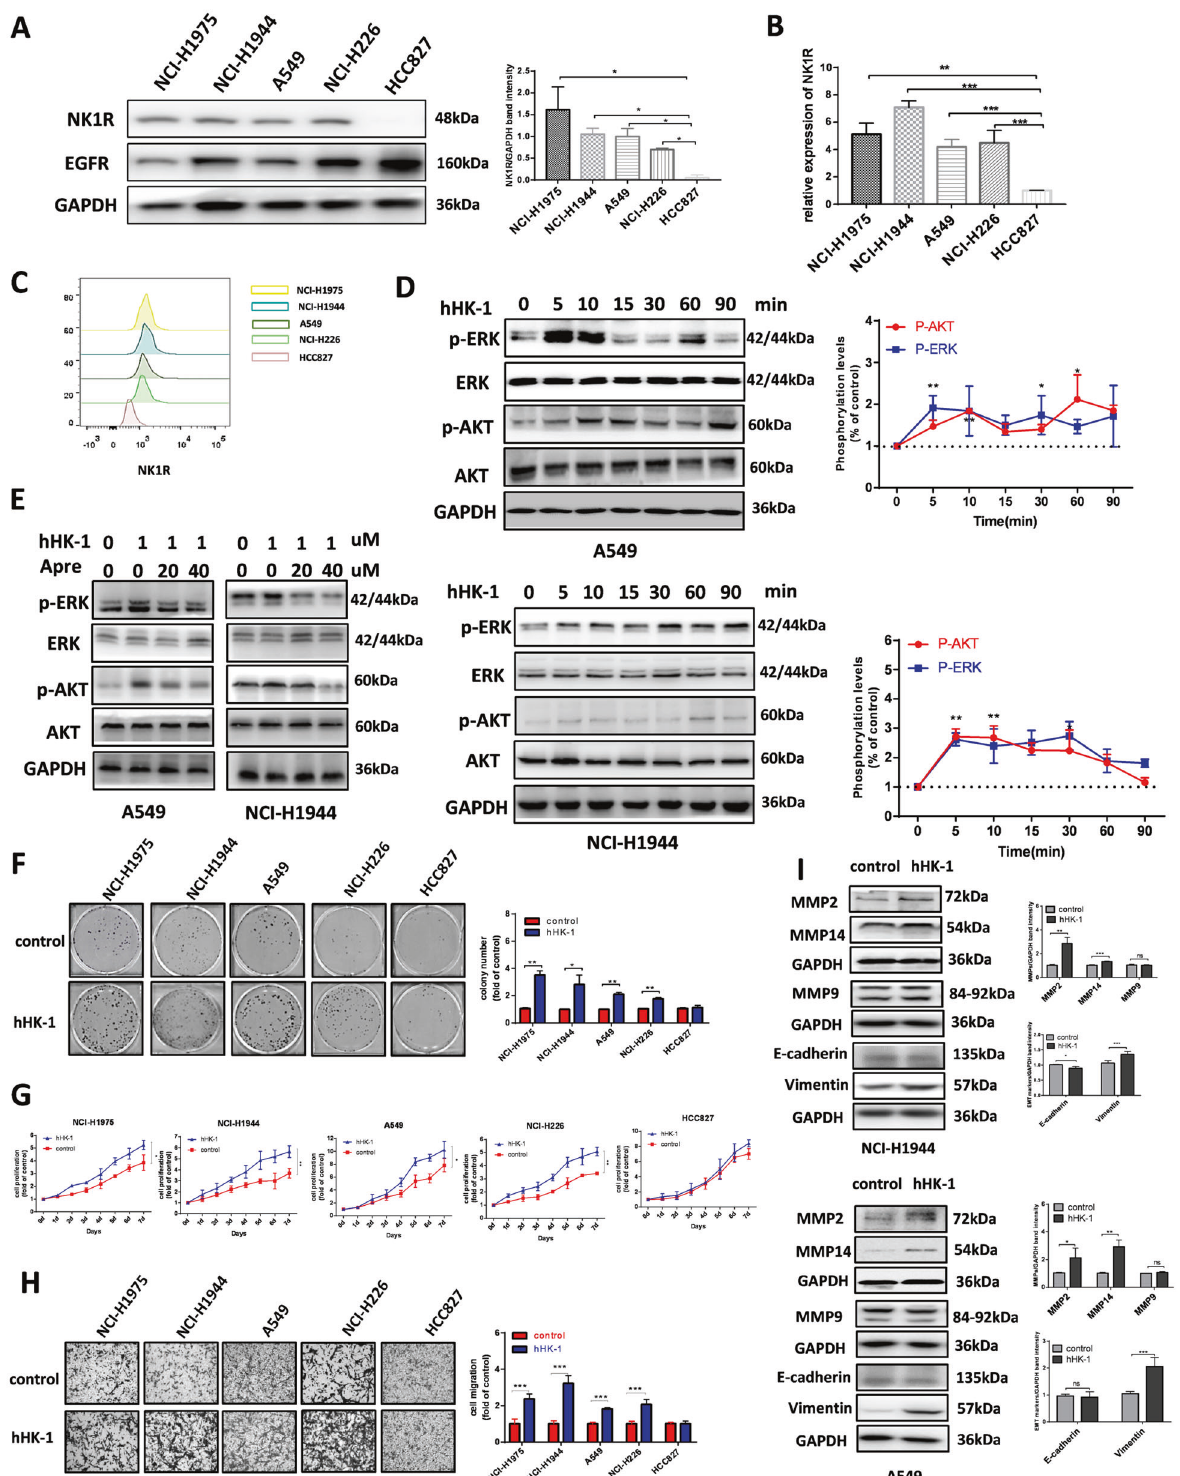
Fig. 2 NK1R promotes NSCLC progression in vitro. A Western blot and B real-time PCR analysis of NK1R expression in NSCLC cell lines. C FACS analysis of NK1R expression on cellular surface membrane. HCC827 cell lysate was used as a negative control. D Western blot analysis of hHK-1 induced ERK1/2 and Akt phosphorylation in NSCLC cell lines. E Aprepitant reduced the phosphorylation of ERK1/2 and AKT triggered by hHK-1. Total ERK1/2 and Akt were used as a loading control. The effect of NK1R activation by 1 μ M hHK-1 on F cell colony formation (colonies larger than 0.1 mm in diameter were counted), G cell growth curve, H transwell cell migration, and I E-cadherin/vimentin, MMP2/14 protein level. The densitometric analysis of each band was calculated with Image J software. Data were shown as mean ± SD from three independent experiments. * P < 0.05, ** P < 0.01, *** P < 0.001.